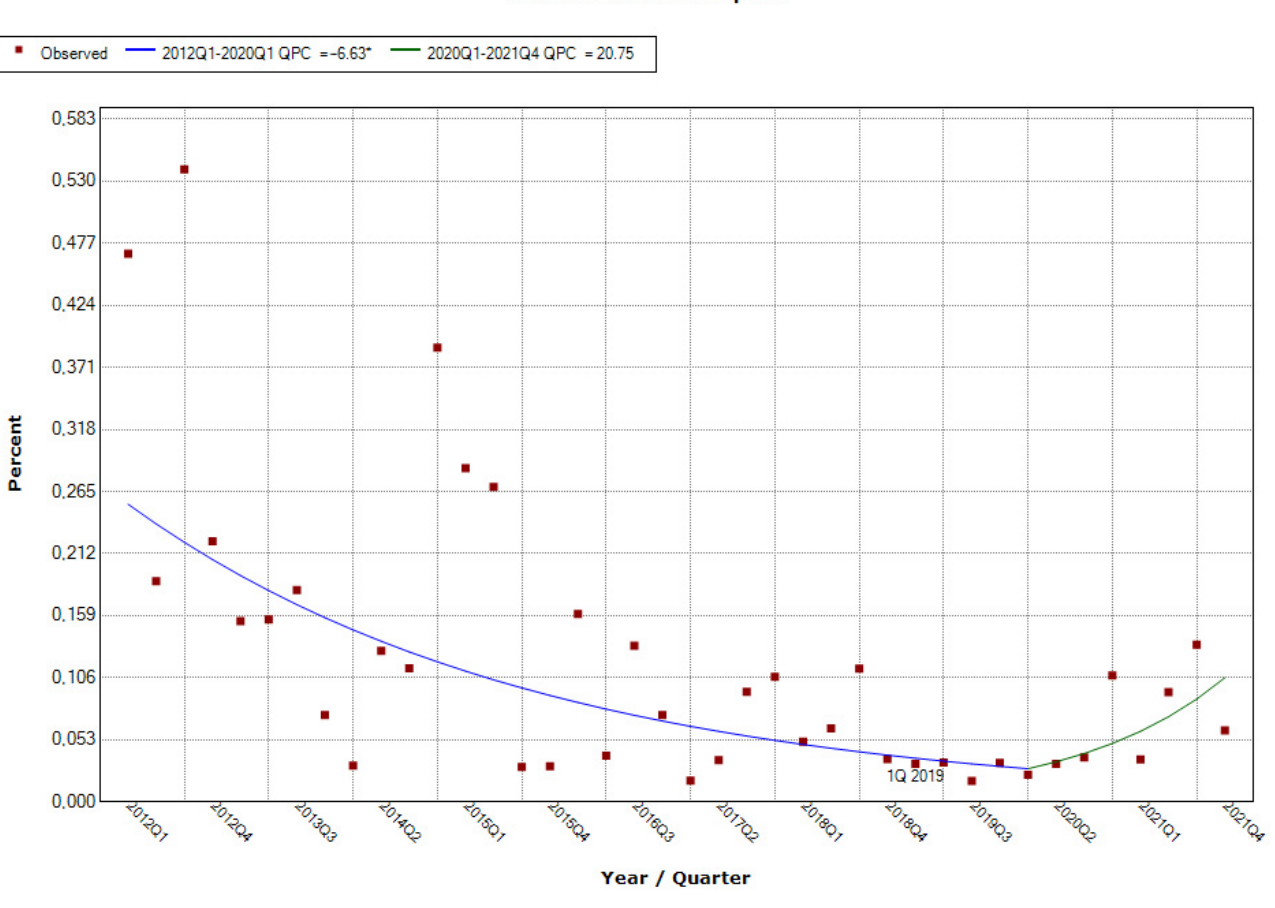
Figure A21. Percentage of products containing isoflavones in individual quarters in the period from 2012 to 28 November 2021. Joinpoints mark trend turning points. The date above the observation indicates the moment of publication of the scientific opinion/resolution.